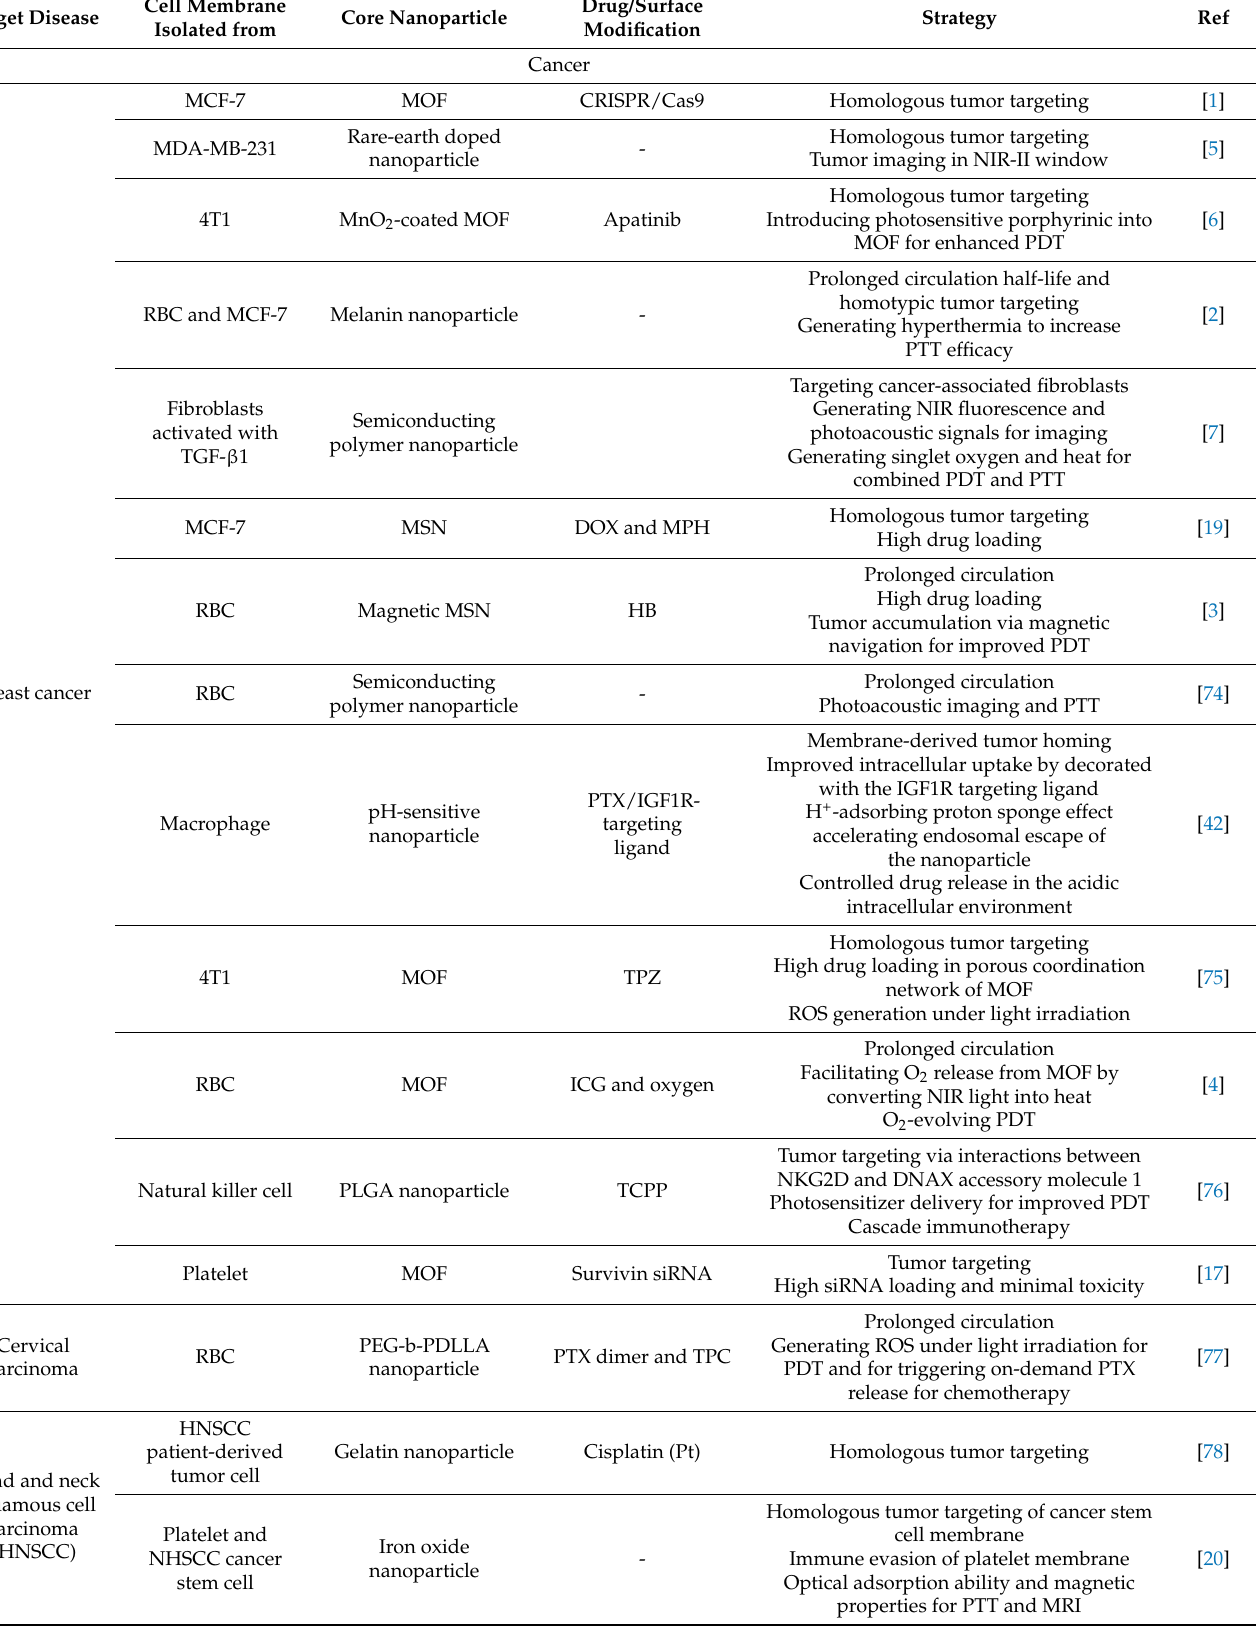
Table 2. Summary of cell membrane-based nanotherapeutics for targeted drug